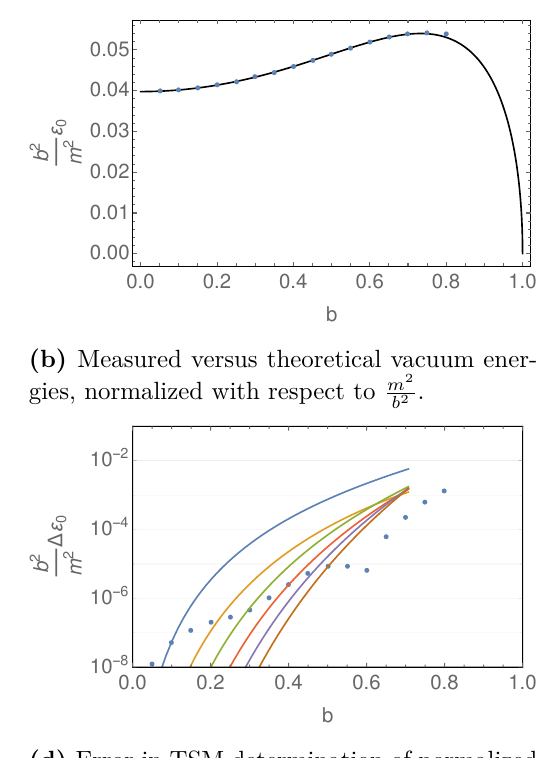
(c) Error in TSM determination of normal- (d) Error in TSM determination of normalized ized masses. vacuum energies. Figure 11. Measured mass (a) and vacuum energy (b) from TSM (blue dots) plotted against the solid theoretical curve. In panels (c) and (d), the error in the TSM results (i.e. the normalized difference between the TSM results and the theoretical values) are presented. We also present the differences between a Feynman perturbative expansion in b with the exact formula. Shown are differences for orders b 4 (blue), b 6 (orange), b 8 (green), b 10 (red), b 12 (purple), and b 14